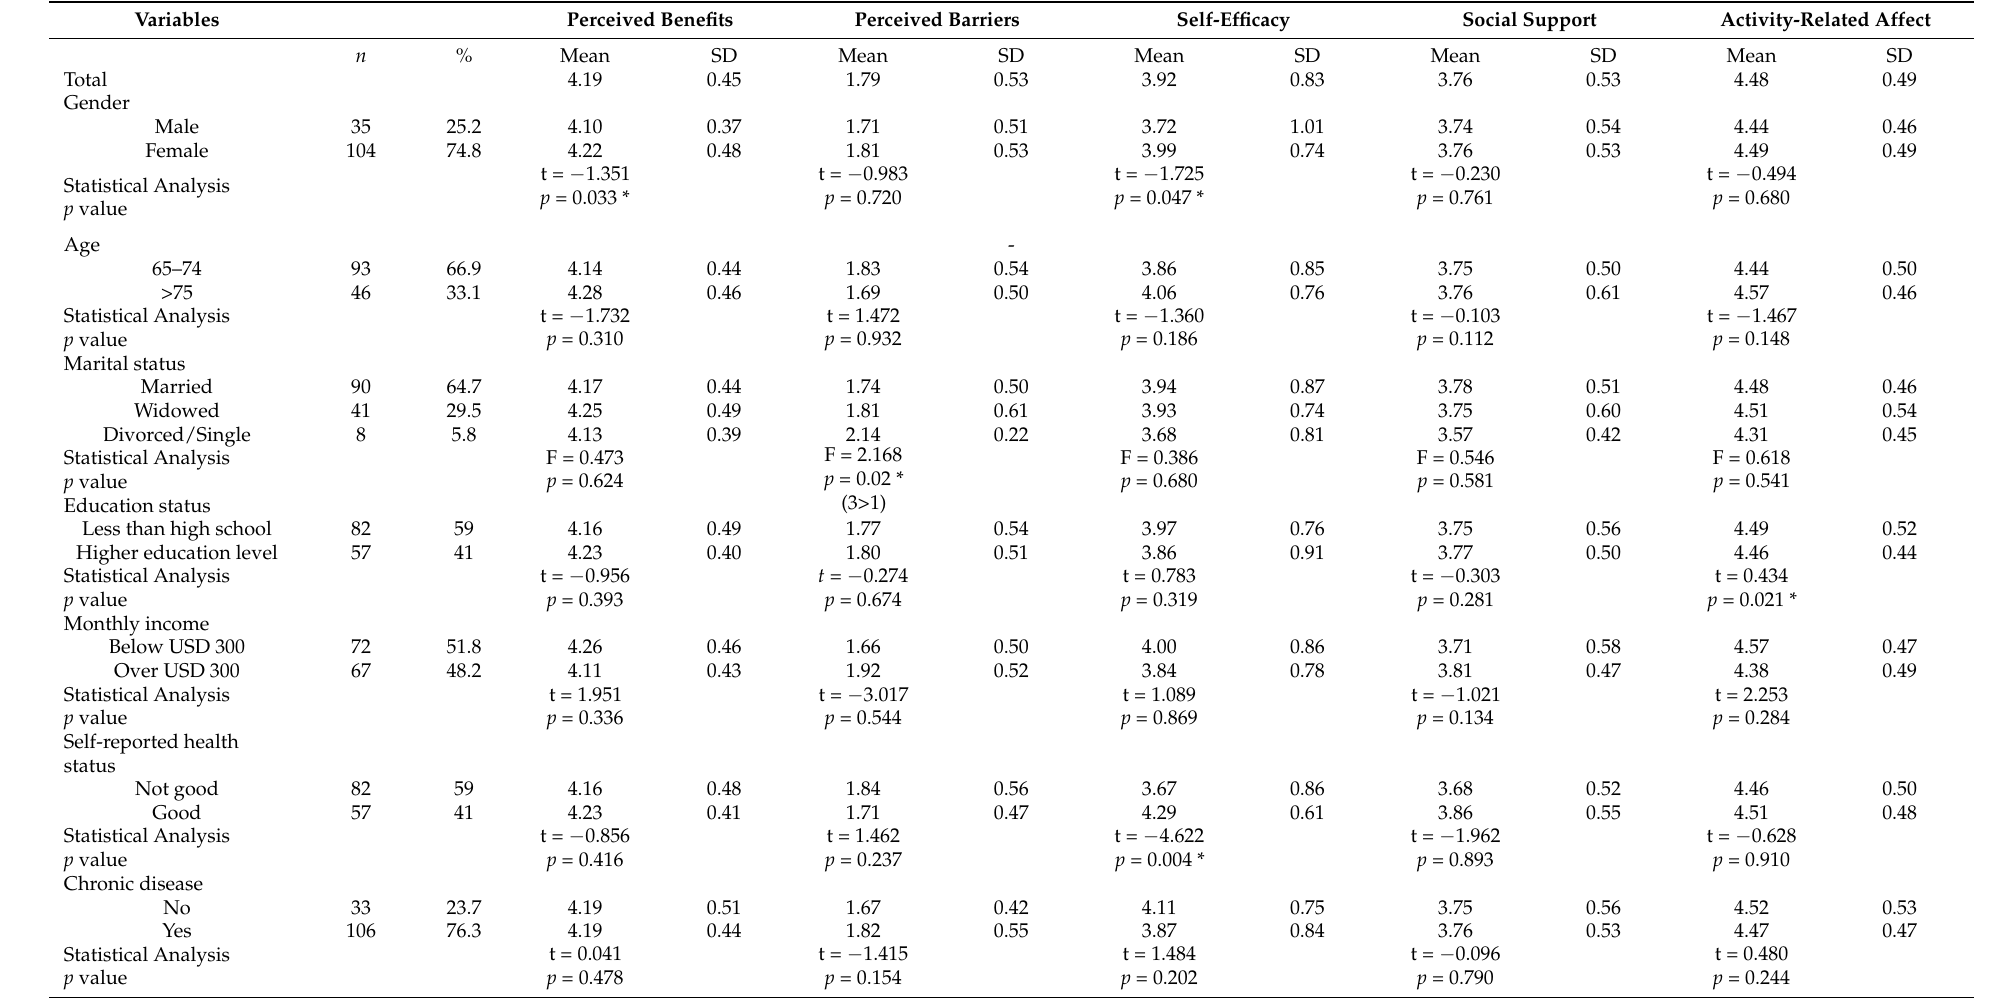
Table 1. Comparison of participants’ characteristics and the Health Promotion Questionnaire with all subscales ( N =